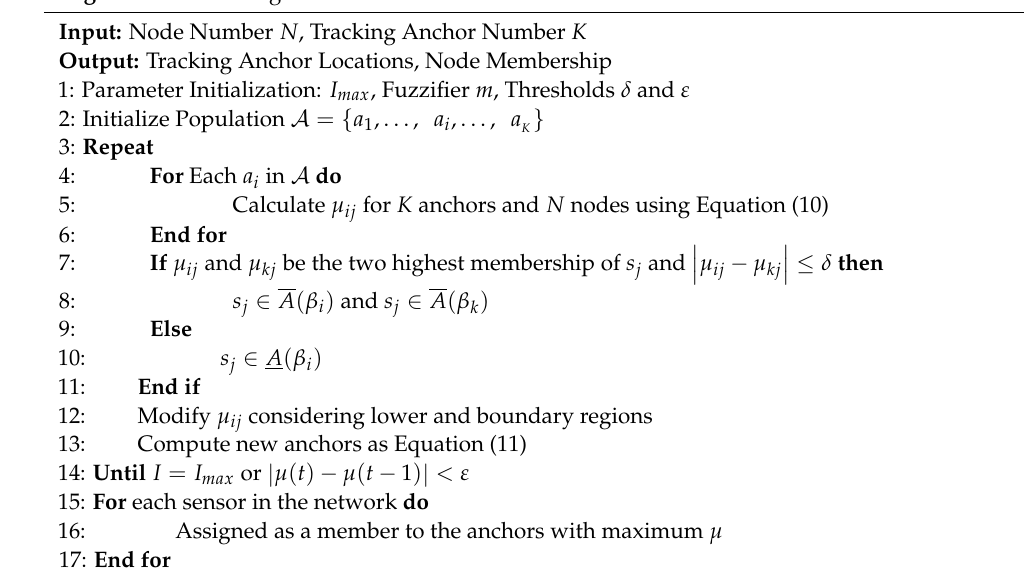
Algorithm 1. Tracking Anchor Determination Based on